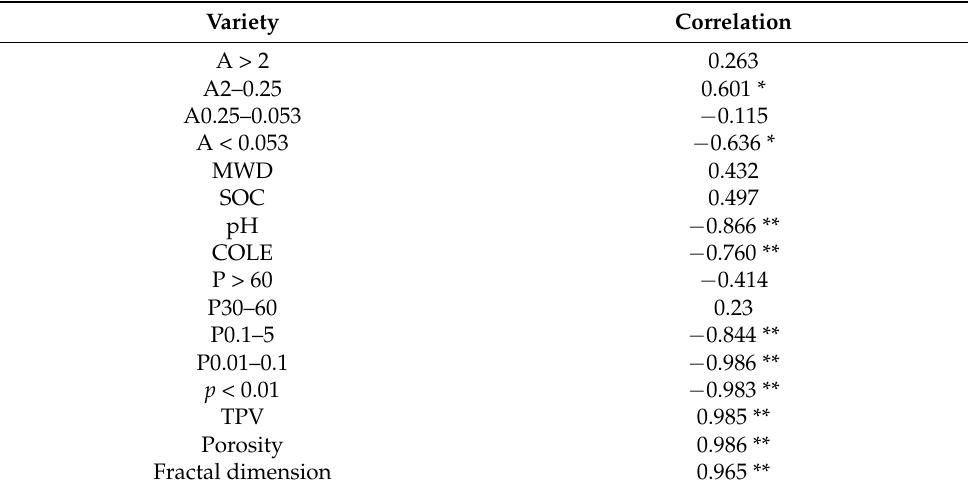
Table 4. Correlation between micropore volume and equivalent pore diameter (5–30 µ m) and different varieties.